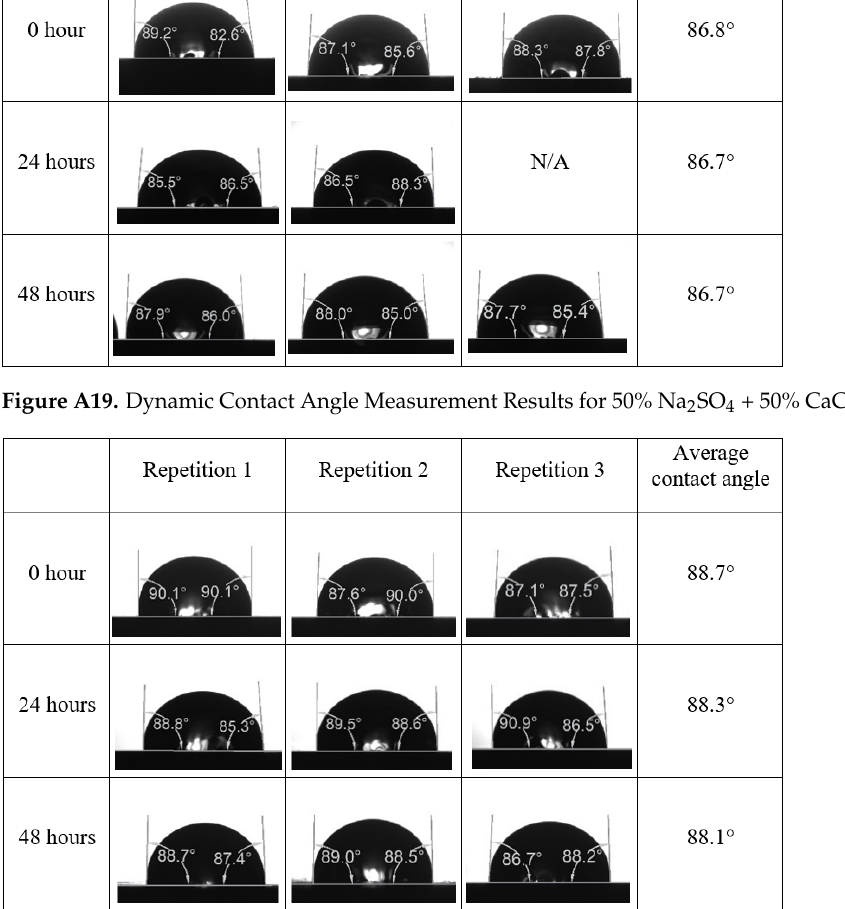
Figure A20. Dynamic Contact Angle Measurement Results for 25% Na 2 SO 4 + 75% KCl (3500